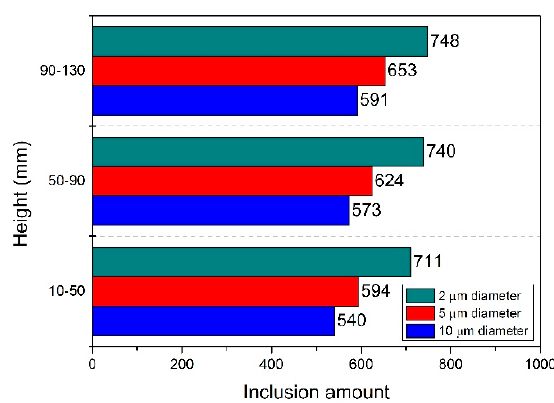
Figure 17. Effect of particle diameter on the inclusion distribution along height in ingot.